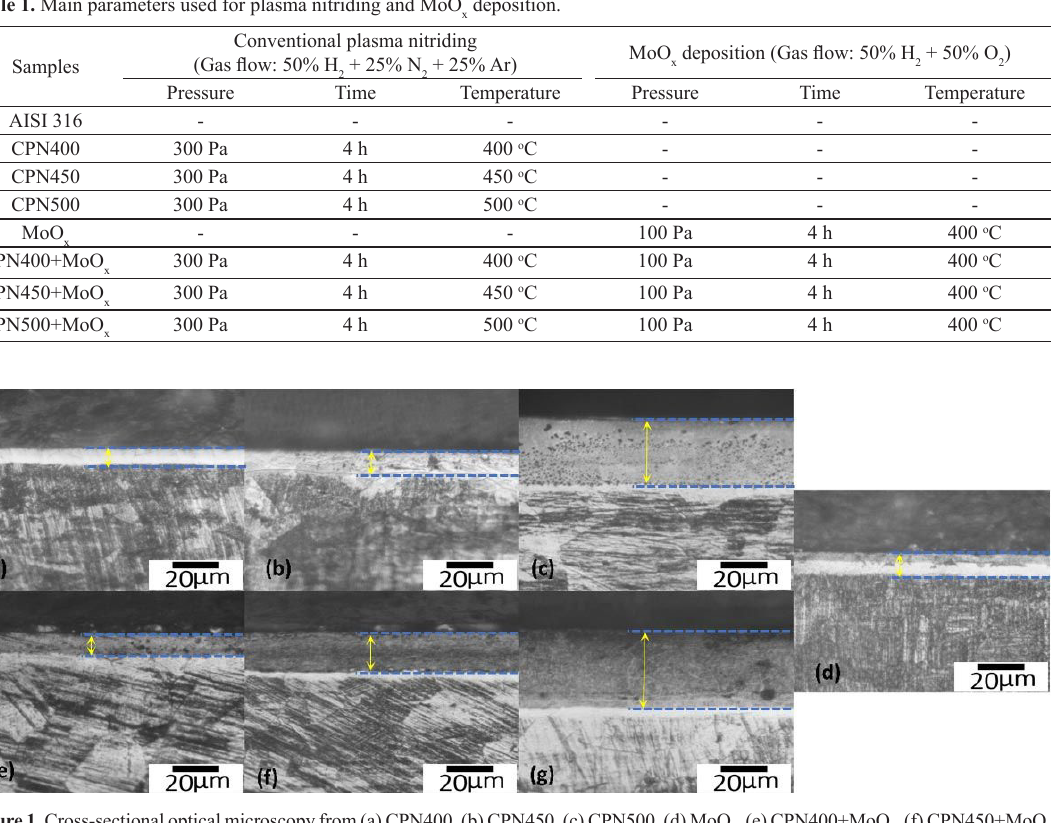
Figure 1. Cross-sectional optical microscopy from (a) CPN400, (b) CPN450, (c) CPN500, (d) MoO and (g) CPN500+MoO